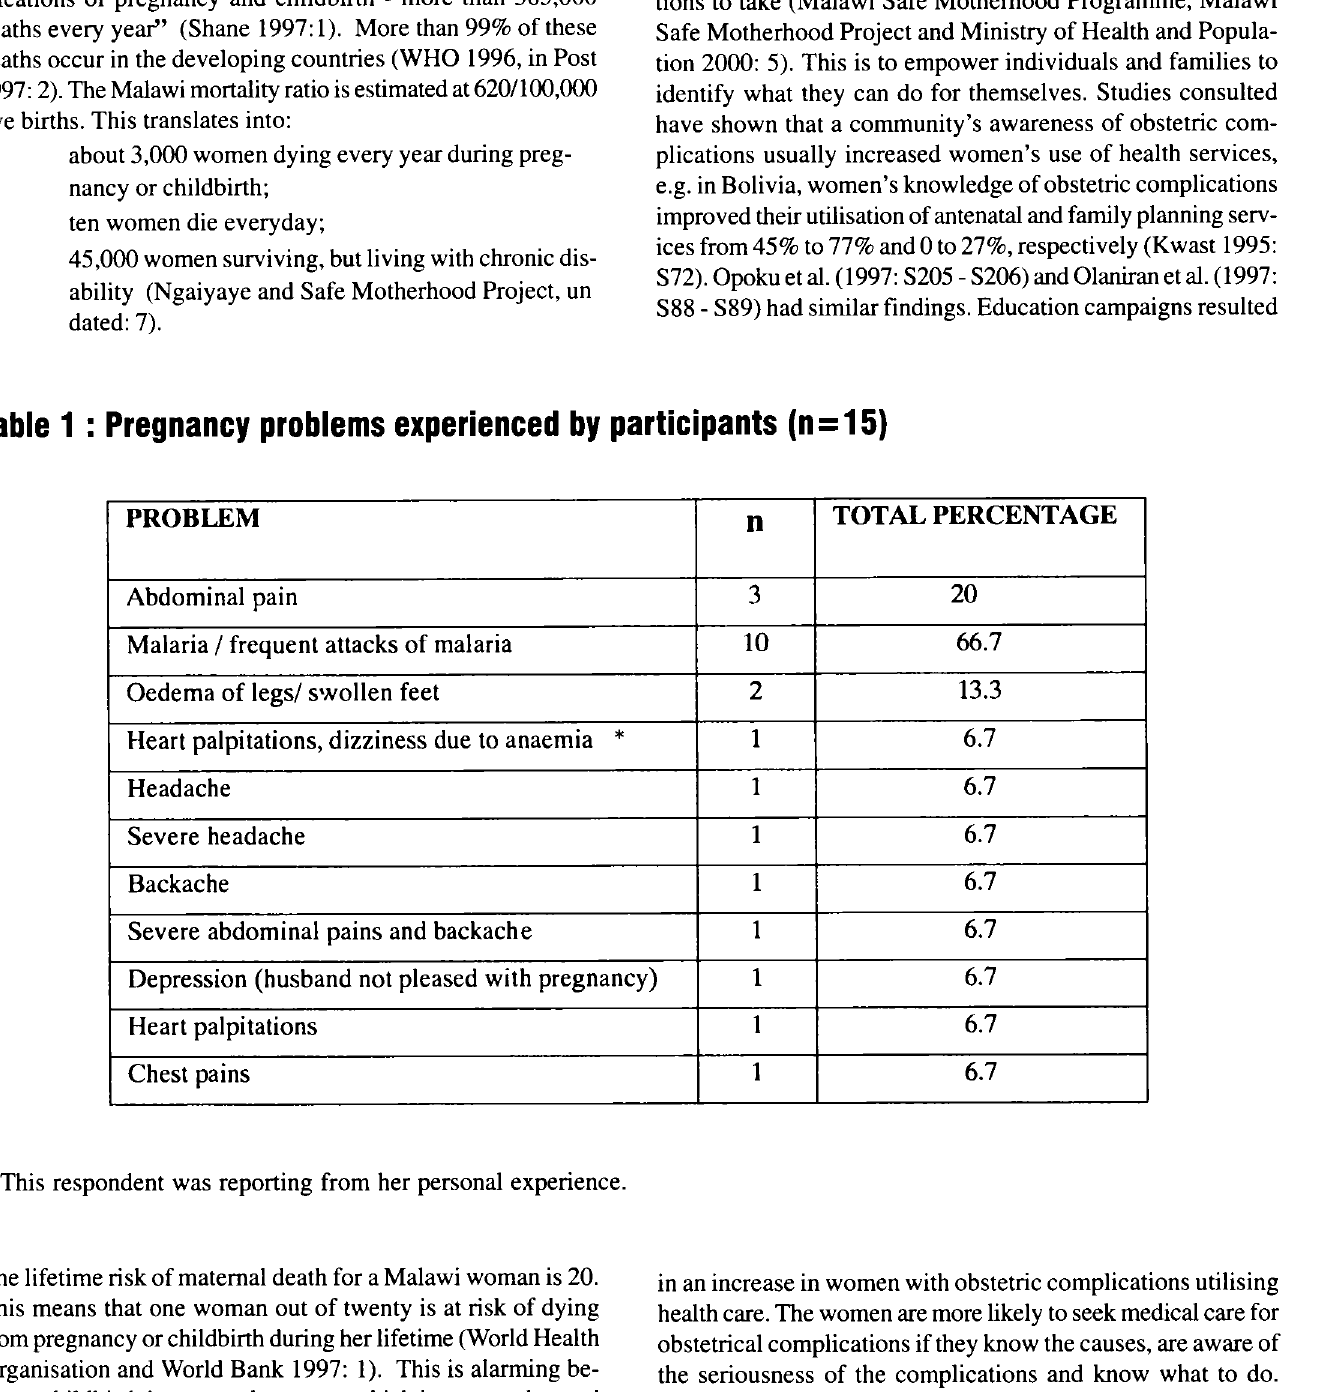
Table 1 : Pregnancy problems experienced by participants (n = 15 )